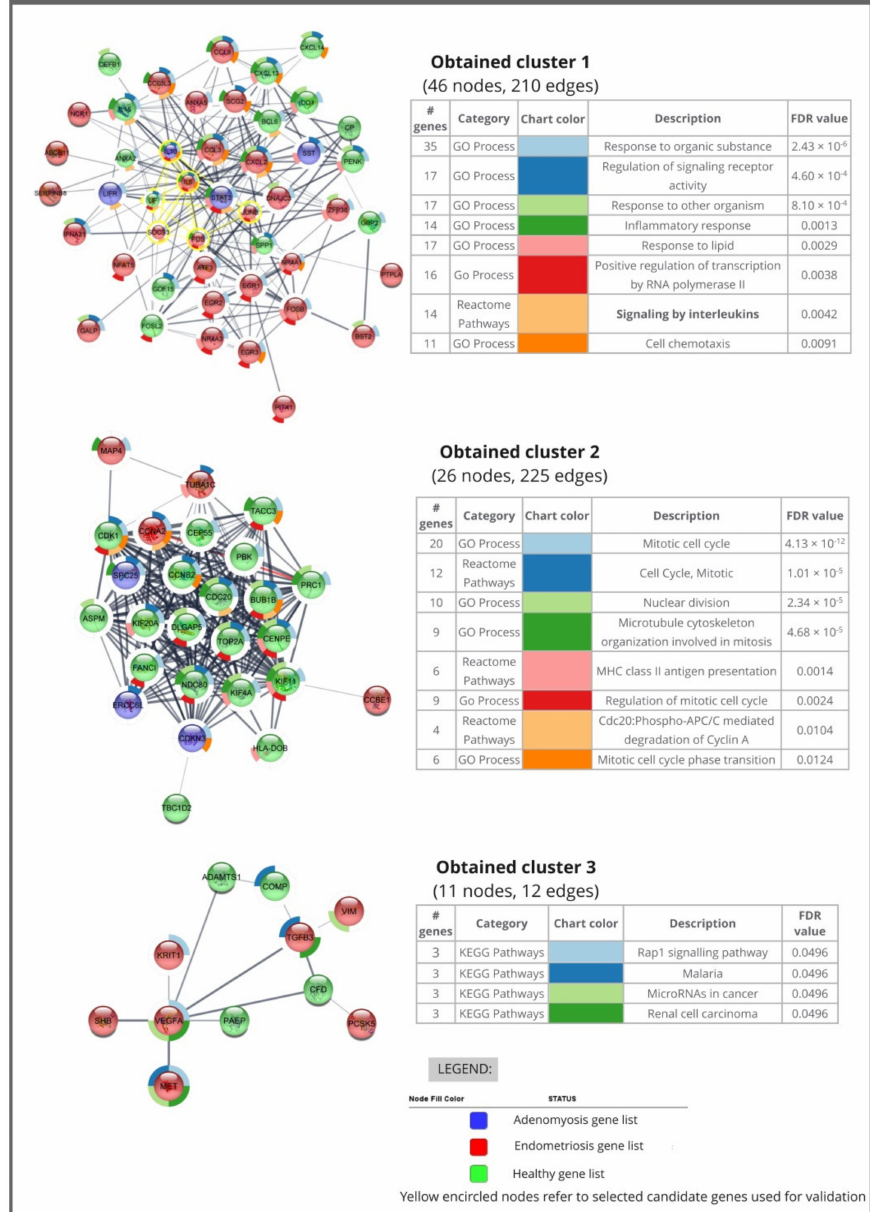
Figure 3. Clusters with more than 10 nodes obtained from PPIN associated with endometrial receptivity in women with adenomyosis or endometriosis and healthy women. GSEA was applied for enriched pathways and annotated nodes were coloured in split donut charts. Signalling by interleukins pathway (marked in bold) from cluster 1 served as a source for prioritisation of genes for validation experiment. Complete PPIN is provided in Supplementary Figure S1. STRING database projected retrieved gene symbols ADGRF1 , HACD1 , GUCY1B1 , CCN1 , TMSB15A and RETREG1 in the PPIN as GPR110, PTPLA, GUCY1B3, CCNA2, TMSNB and FAM134B,